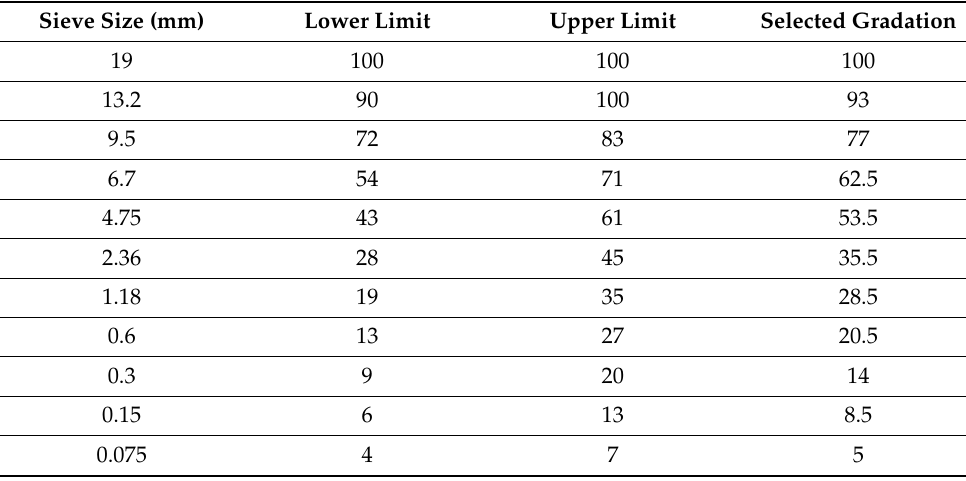
Table 2. Particle-size distribution of dense graded